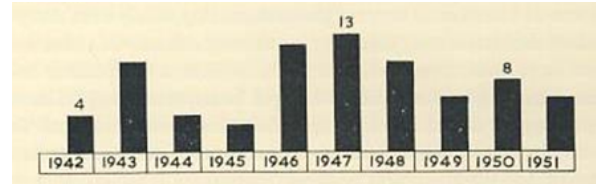
Figure 7. The diagram of Gartlein (1952) for the frequency of hy- drogen line detections in the aurora between 1942 and